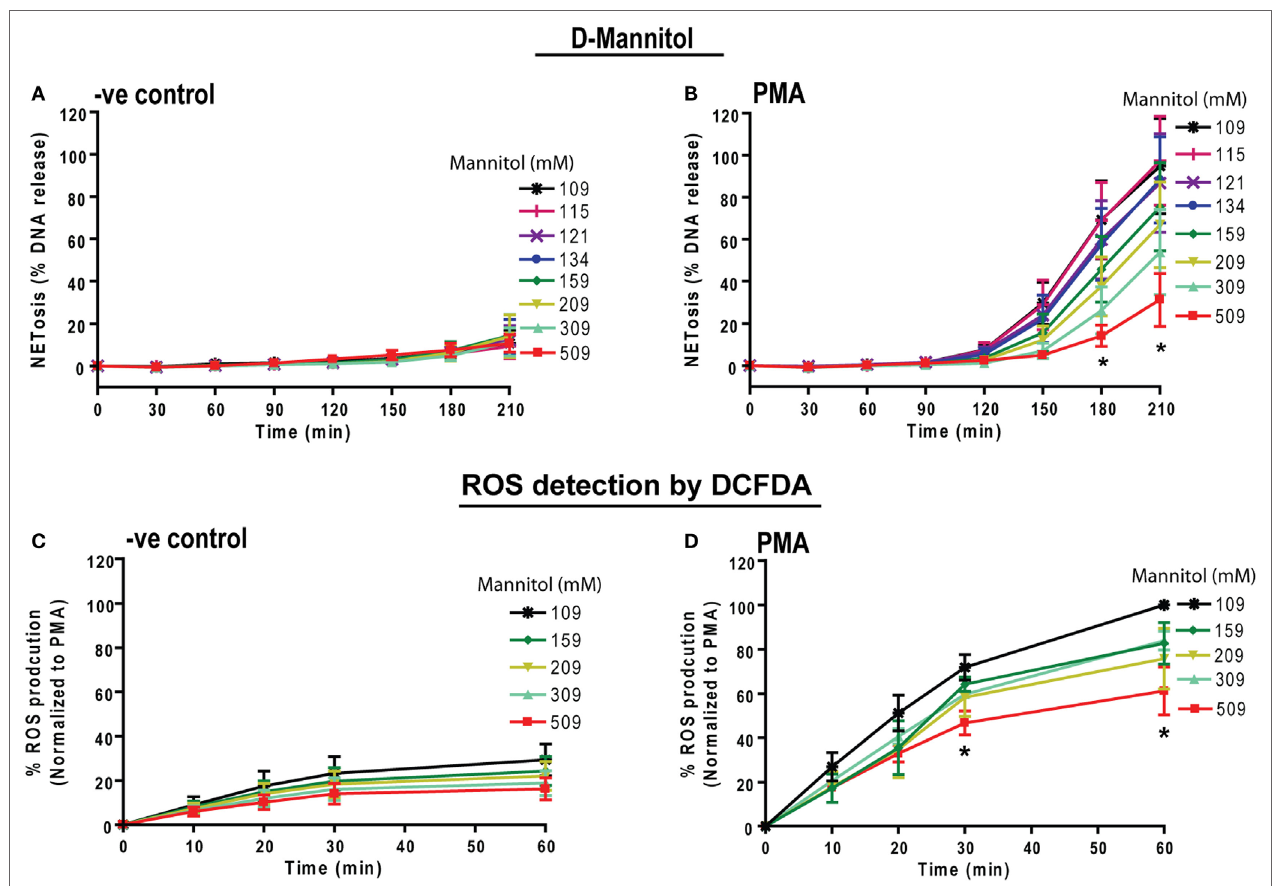
FigUre 4 | Increasing concentrations of d -mannitol suppress phorbol myristate acetate (PMA)-mediated reactive oxygen species (ROS) production and NETosis. Human neutrophils were treated with d -mannitol and d -sorbitol to determine the effects of osmolarity during NETosis. (a) Unstimulated neutrophils treated with d -mannitol showed no suppression in background NETosis. (B) In contrast, PMA-treated cells in different concentrations of d -mannitol showed significantly lower NETosis in a dosage-dependent manner ( n = 3, * p < 0.05; two-way ANOVA with Bonferroni’s multiple comparison post test). ROS production was measured by using neutrophils preloaded with DCFDA under different d -mannitol concentrations. (c,D) The ROS production in PMA-activated neutrophils is suppressed by high d -mannitol concentrations ( n = 3, * p < 0.05; two-way ANOVA with Bonferroni’s multiple comparison post test). Similar to d -mannitol, d -sorbitol treatment did not alter background NETosis activation in − ve control while it suppresses PMA-induced NETosis. See Figure S4 in Supplementary Material for d -sorbitol